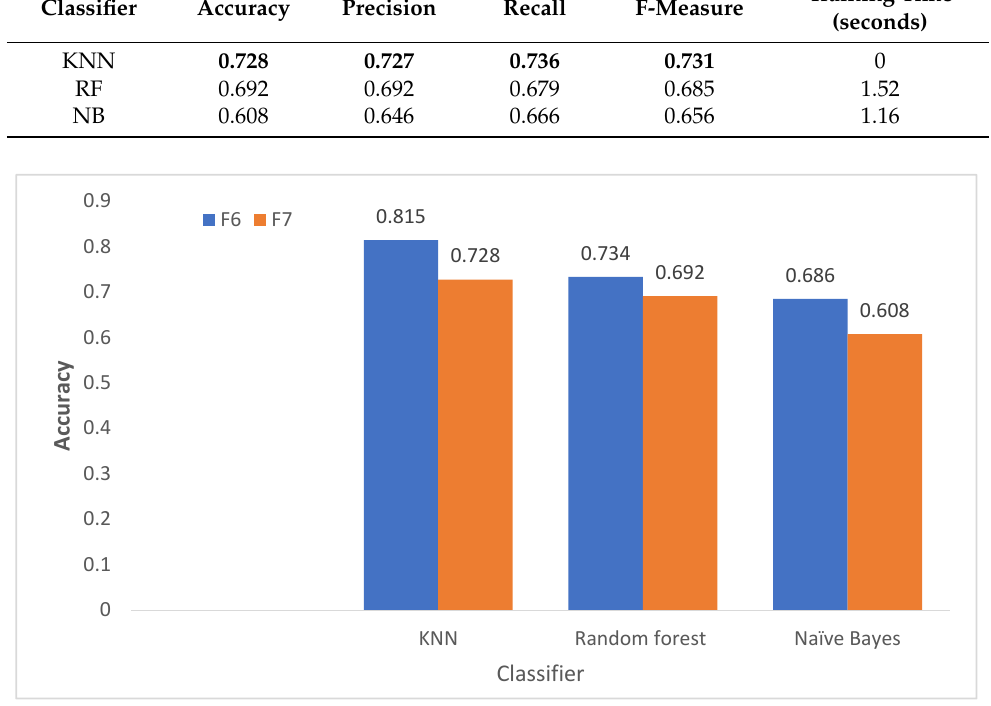
Figure 3. Classifier identification accuracy on each of F6 and F7 deep features. Accuracy results obtained from Tables 3 and 4.